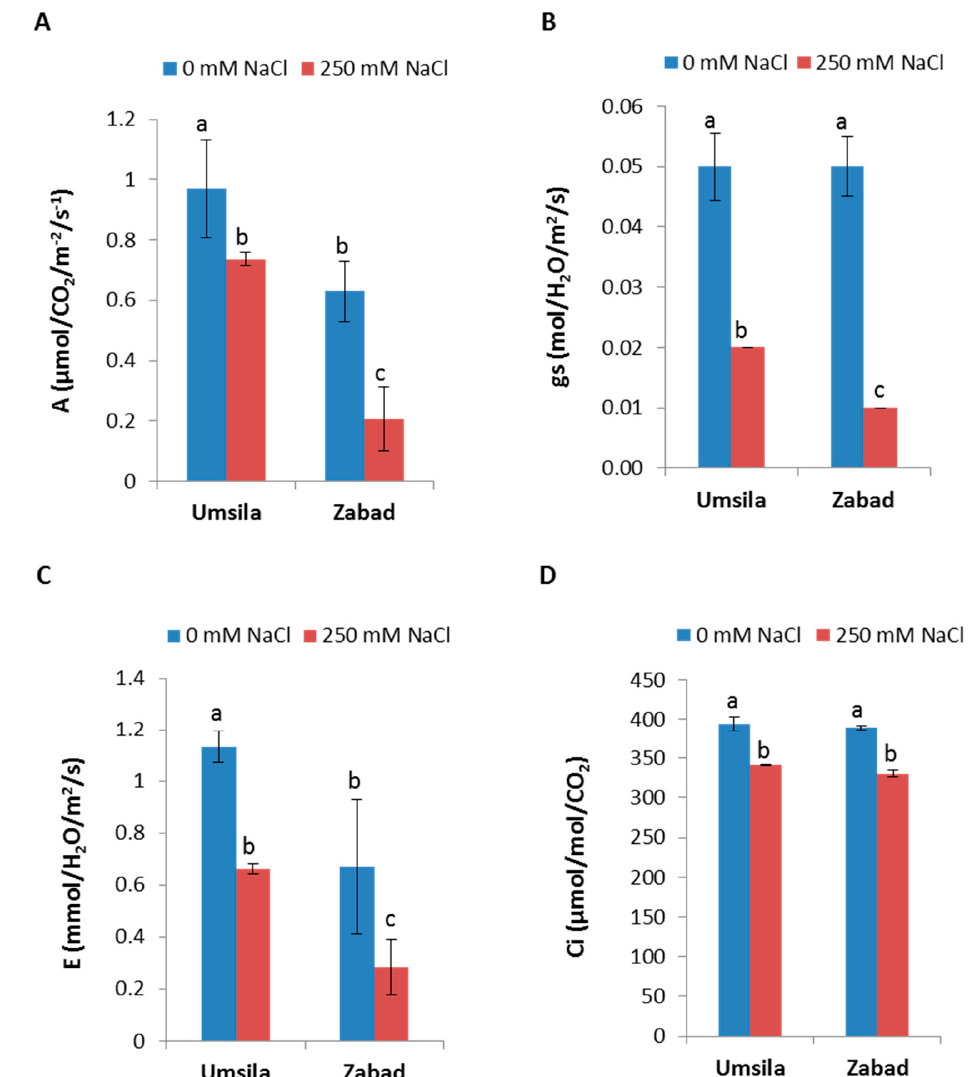
Figure 2. Photosynthesis parameters are affected by saline stress. The effect of salinity on the ( A ) photosynthetic rate ( A ), ( B ) stomatal conductance ( gs ), ( C ) transpiration rate ( E ), and ( D ) intercellular CO 2 concentration ( Ci ) of cultivars “Umsila” and “Zabad” when exposed to 0 mM and 250 mM NaCl. The bars represent the mean ± SE (n = 3). Significant differences were calculated based on p ≤ 0.05. The bars with the same letter are not significantly different.